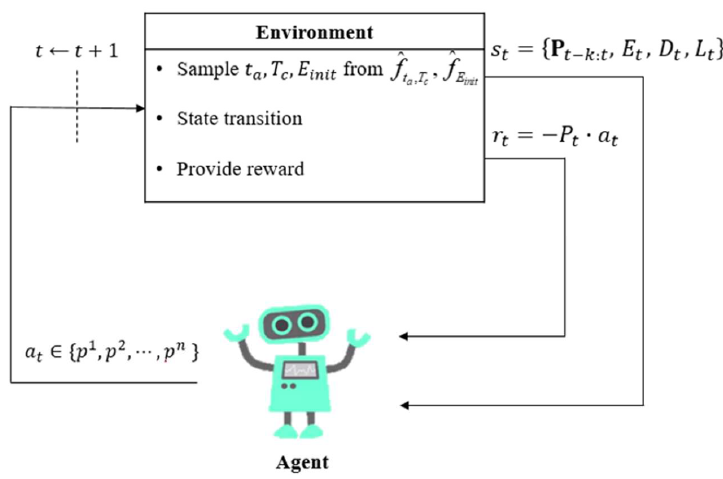
Figure 2. An interaction between a reinforcement learning (RL) agent and an environment . 186